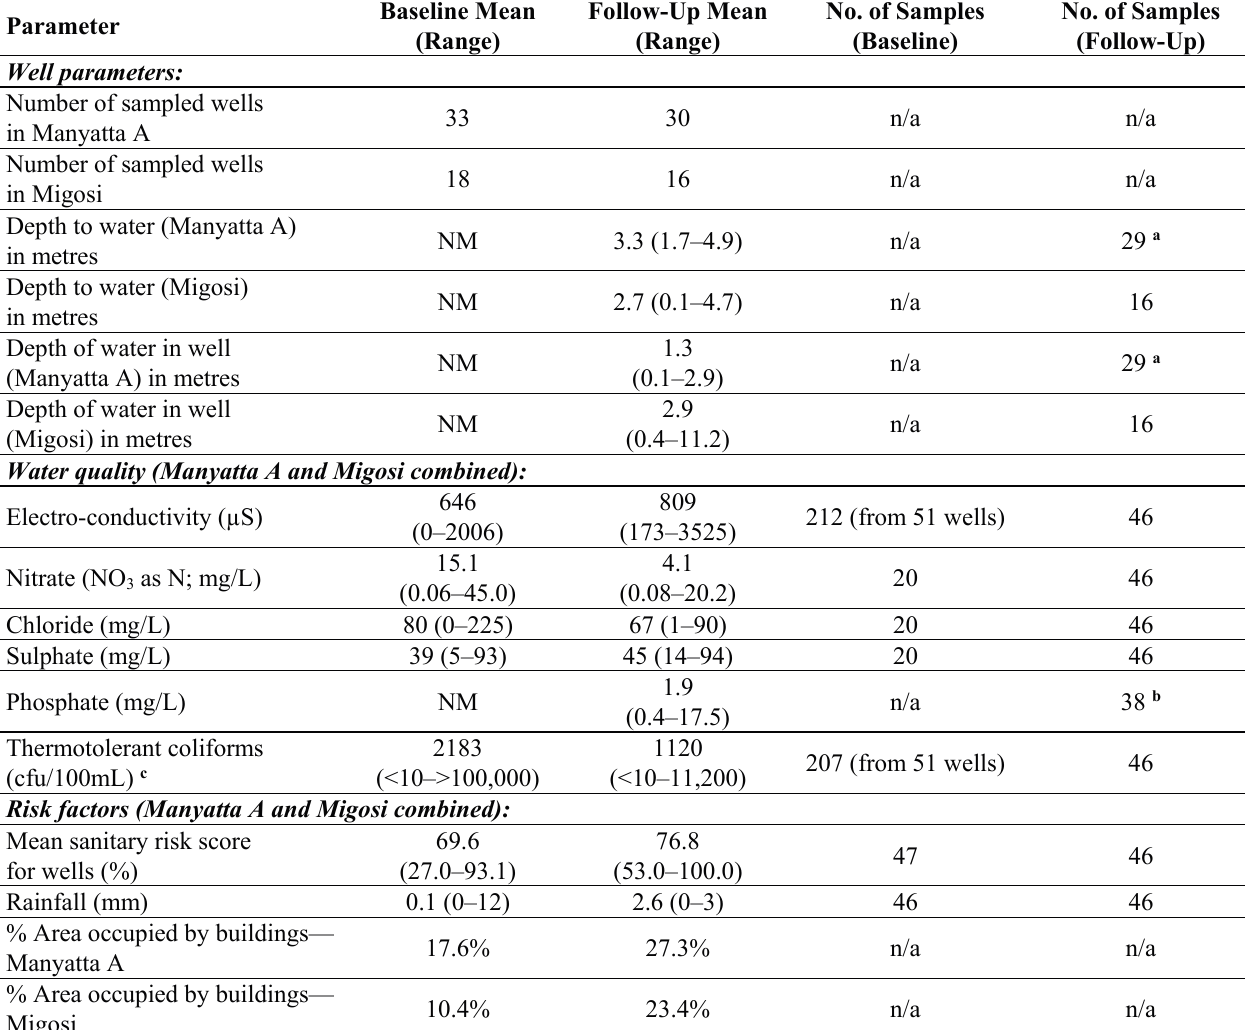
Table 1. Summary of well and water quality parameters and selected potential contamination risk factors (arithmetic means unless otherwise